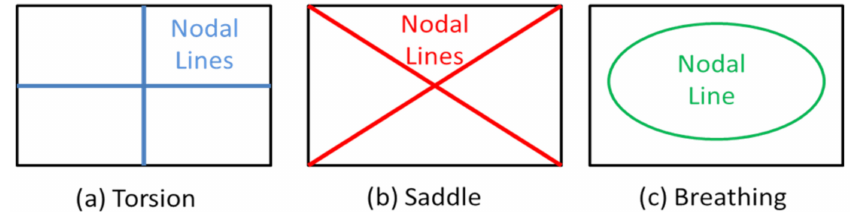
Figure 6. Nodal lines of three mode shapes. ( a ) The nodal lines of the torsion mode shape, ( b ) the nodal lines of the saddle mode shape, ( c ) the nodal line of the breathing mode shape.